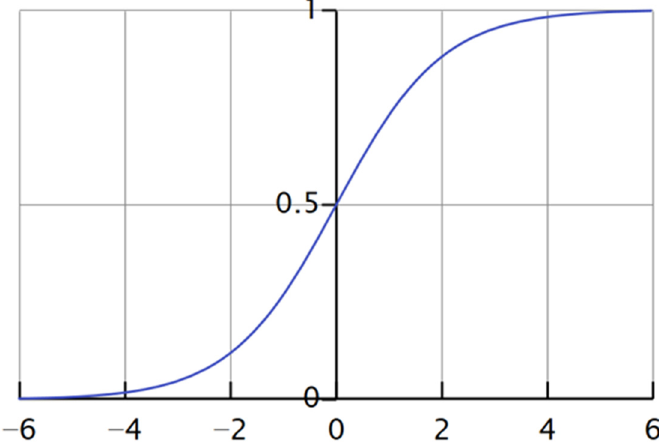
Figure 1. Graphic representation of the logistic function (Author’s development).